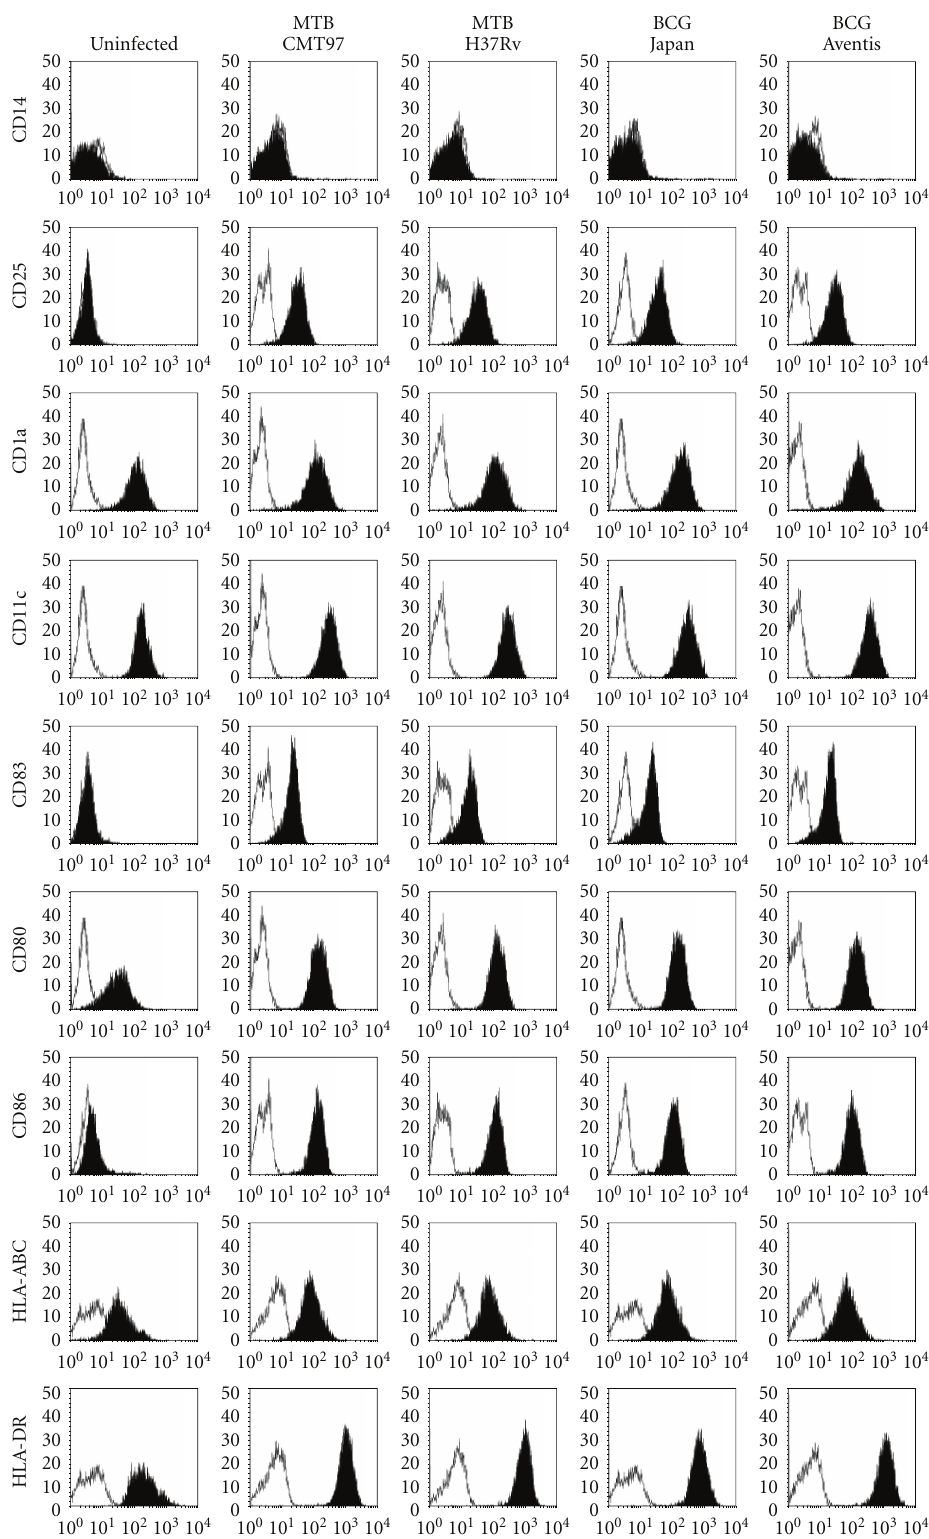
Figure 1: Flow cytometry analysis of phenotype markers on DCs infected with di ff erent mycobacterial strains. DCs, obtained from the same donor, were exposed to MTB H37Rv, MTB CMT97, BCG Aventis and BCG Japan for 3 h (MOI, 1) or left uninfected. Flow cytometric analysis of typical membrane molecule expression was performed 24h after exposition to mycobacteria. Fluorescence histograms for each surface molecule (filled histograms) in comparison with isotype controls (empty histograms) are reported. Data are from a single donor, representative of 7, all with similar